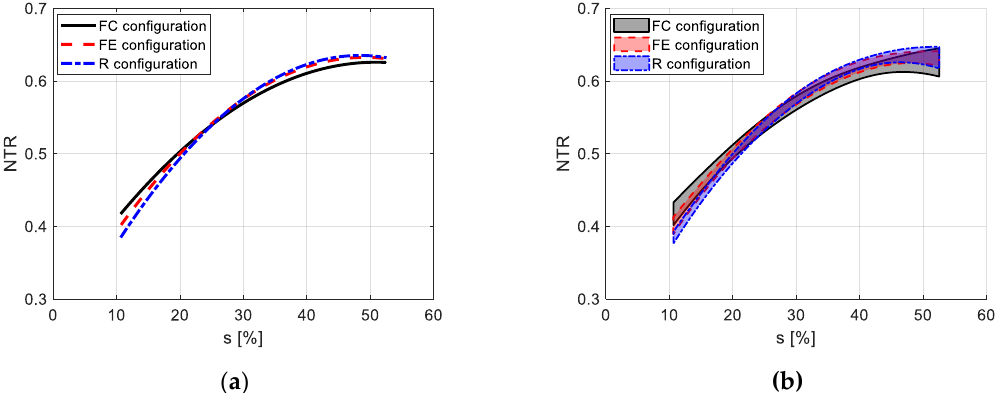
Figure 7. ( a ) η T -s regression curves, and ( b ) prediction bound areas for tractor configurations FE, FC and R. Regression coefficients are listed in Table 7. The lower and upper slip values for the models are 11 and 52%, respectively.